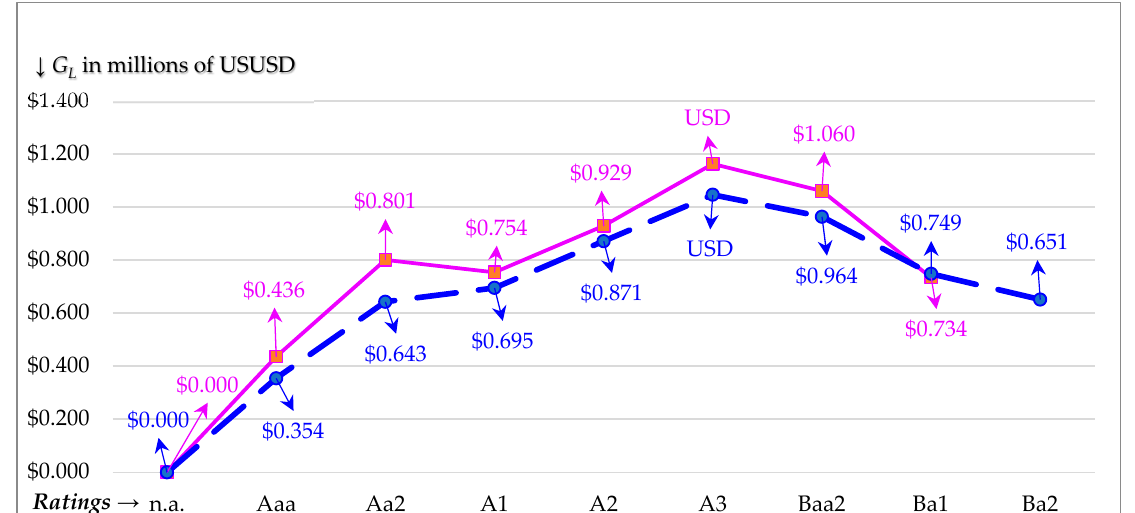
Figure 2. Gain to leverage ( G L ) values are plotted along the vertical axis against Moody’s credit ratings along the horizontal axis. The nonprofit trajectory is the solid line and the pass-through trajectory is the dashed line. We use credit spreads for 2019, TCJA low ( L ) tax rates, and 3.12% growth where the growth ( RE ) constraint sets in after Ba1 for nonprofits (NPs) and after Ba2 for pass-throughs (PTs). The optimal credit rating ( OCR ) is A3.